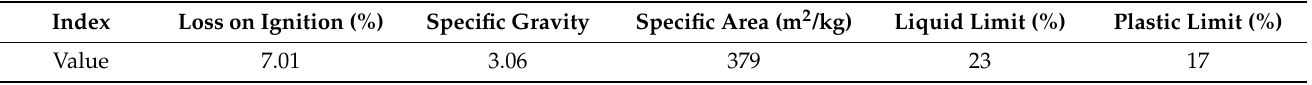
Table 2. Physical and mechanical indexes of iron